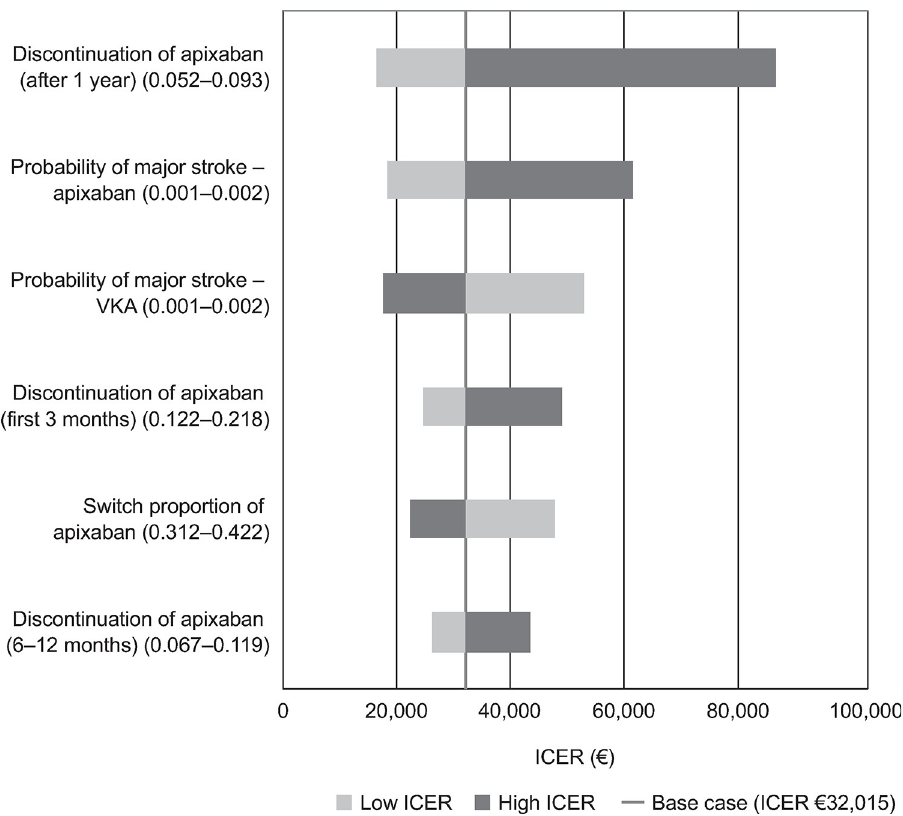
Fig 3. Apixaban tornado diagram. ICER, incremental cost-effectiveness ratio; VKA, vitamin K antagonist.